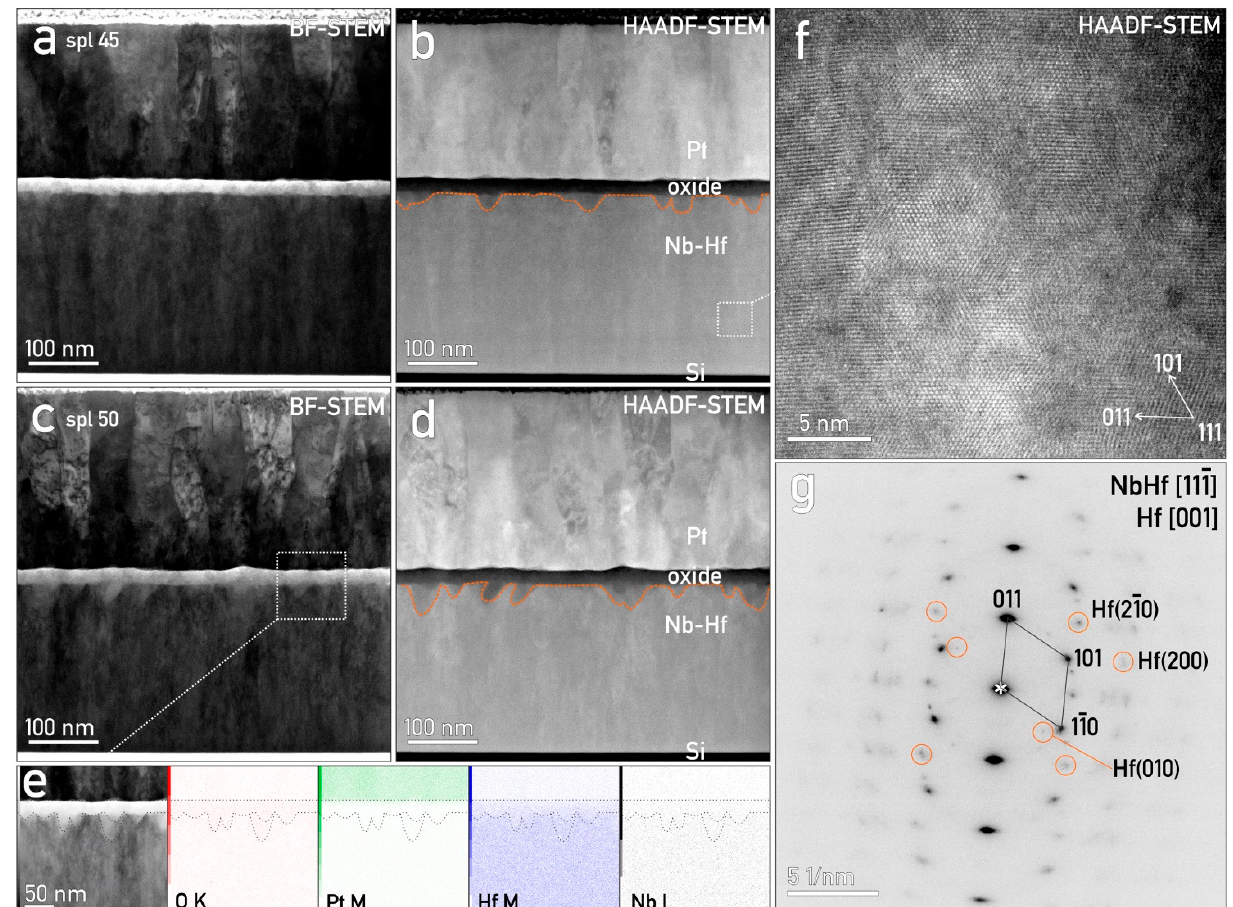
Figure 1. General outline of the phases present in the sample Nb-45 at.% Hf and Nb-50 at.%Hf. ( a , c ) BF-STEM and ( b , d ) HAADF-STEM micrographs of top Pt electrode with columnar structure, inter- mediate oxide layer, and underlying Hf–Nb metal. ( e ) EDX map of principal chemical components, where both Nb and Hf were present in the oxide layer; ( f ) bulk Hf–Nb showed preferential pillar- like growth with nano-scaled Hf exsolutions. ( g ) SAED of same region, indexed for Hf–Nb and (en- circled) for Hf.